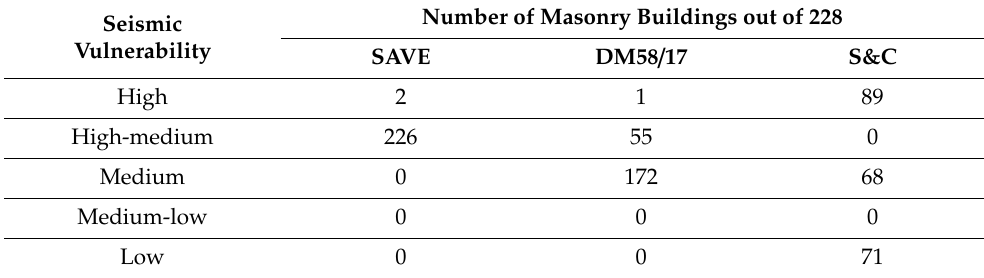
Table 12. Comparisons of vulnerability judgments for 228 masonry buildings given by the methods of Group A.